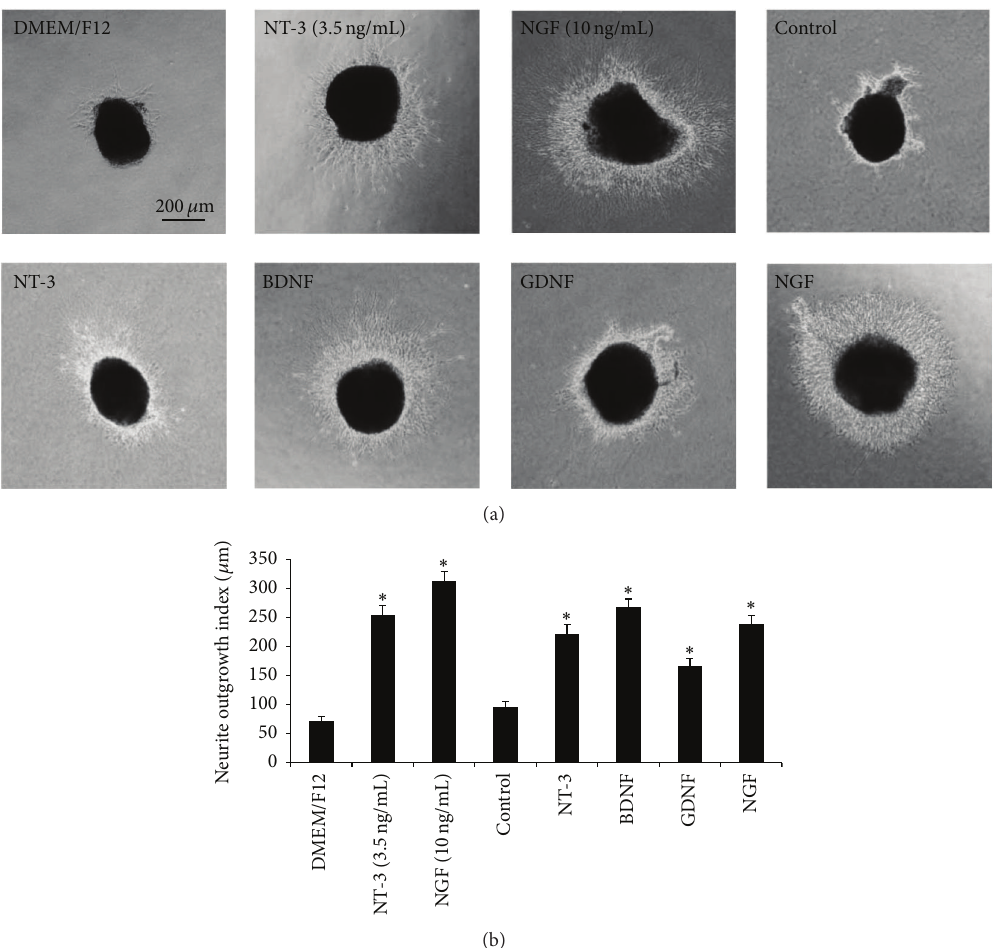
Figure 7: Effects of overexpression of NTFs from HUMSCs on the neurite outgrowth of embryonic chick DRG. (a) Representative images of E9 DRG culture for 24 hours (scale bar = 200 𝜇 m). (b) DRG cultured in blank culture medium extended short neurites. NT-3 (3.5 ng/mL), NGF (10ng/mL), and overexpression of NTFs from HUMSCs treatment effectively promoted neurite outgrowth. Neurite extension of DRG treated with cell culture supernatant of HUMSCs (control) was similar to that of blank group. ∗ 𝑃 < 0.05 versus blank or control ( 𝑛 = 10